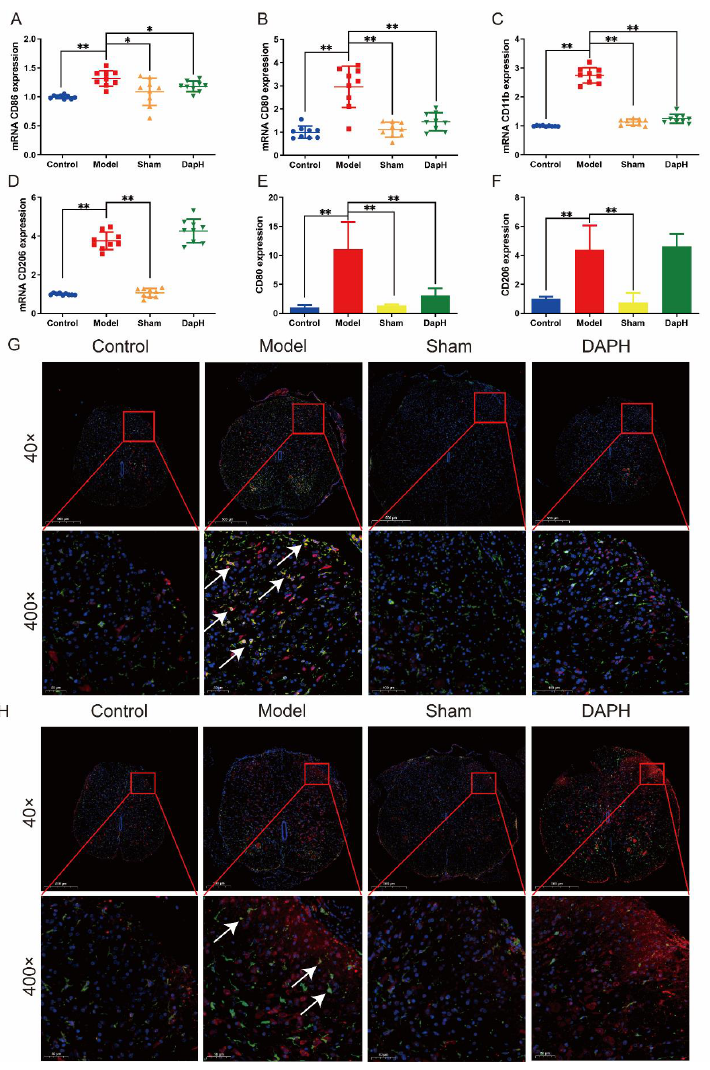
Figure 3. Effect of daphnetin on microglia polarization in the spinal cord of NP rats. ( A − C ) mRNA expression of M1 microglial cell markers in the spinal cord ( n = 3). ( D ) mRNA expression of M2 microglial cell markers in the spinal cord ( n = 3). ( E ) Immunofluorescence intensity of CD80 in im- munofluorescence sections ( n = 3). ( F ) Immunofluorescence intensity of CD206 in immunofluores- cence sections ( n = 3). ( G ) Immunofluorescence double staining of CD80 (red) and Iba − 1 (green) in the spinal cord of NP rats ( n = 3), the arrows is the overlap of CD8 0 and Iba−1 . ( H ) Immunofluores- cence double staining of CD206 (red) and Iba − 1 (green) in the spinal cord of NP rats, the arrows is